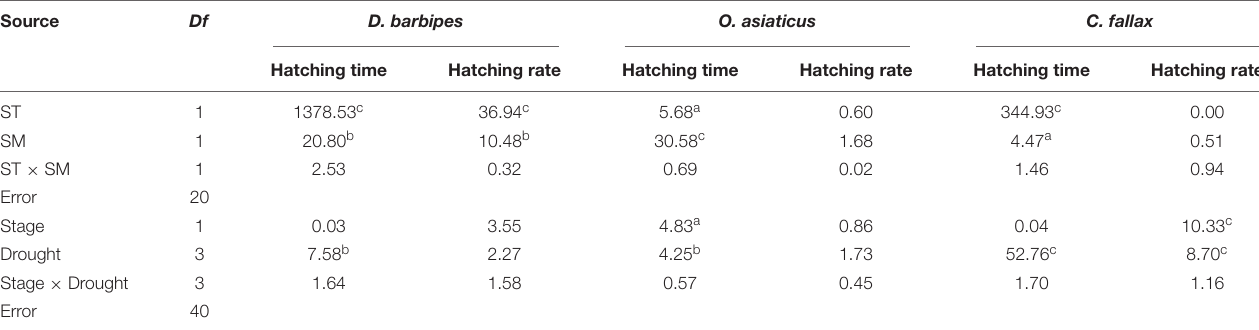
TABLE 1 | Results ( F values) of two-way ANOVAs of the effect of soil temperature (ST) and soil moisture (SM), embryonic development stage, and drought exposure duration on the variation index (VI) of hatching time and hatching rate of eggs of three grasshopper species. Source Df